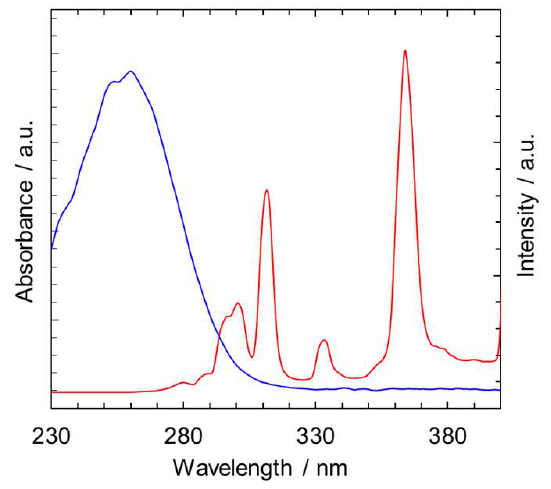
Figure 8. Spectrum of the spot light (red) and the ozone absorption curve (blue).